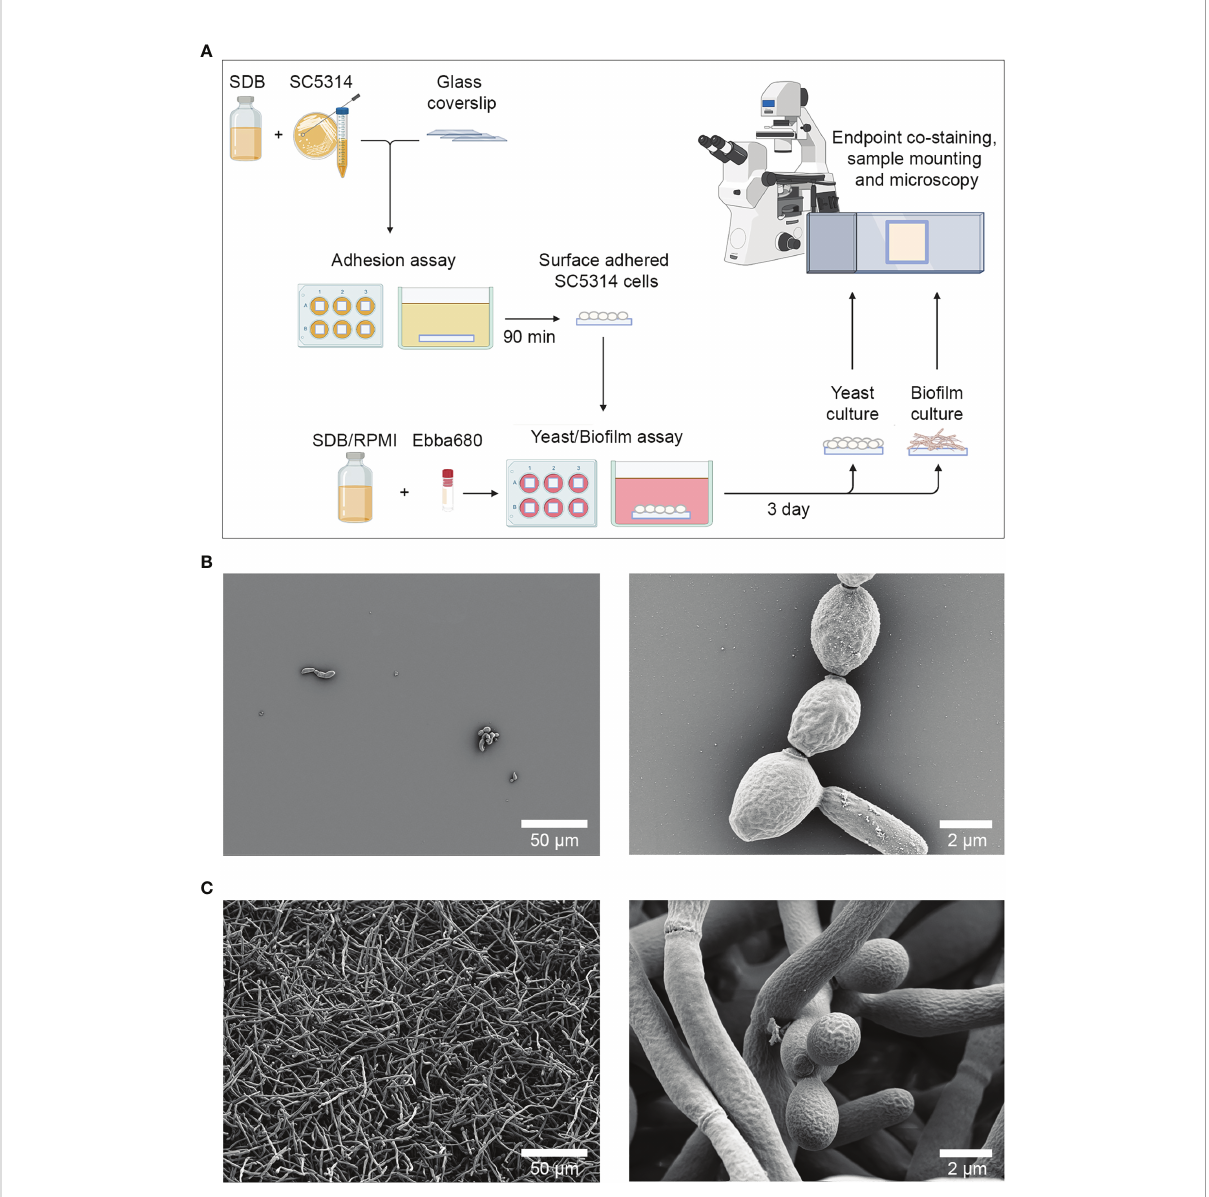
FIGURE 1 Cultivation of surface adhered C. albicans yeast cells and bio fi lms. (A) Work fl ow for producing yeast cells and bio fi lms. Sterile glass coverslips were immersed in 2 mL of C. albicans in SDB for 90 min at 37°C, after which coverslips containing adhered cells were re-incubated in 2 mL of SDB or RPMI with or without Ebba680 in 6 well plates for 3 days at 37°C. Surface adhered yeast cells and bio fi lms were subsequently analyzed by scanning electron microscopy, immuno fl uorescence techniques, confocal microscopy and spectral imaging analysis. (B) Scanning electron micrographs of surface adhered yeast cells at low (left) and higher magni fi cations (right). (C) Scanning electron micrographs of bio fi lm cells at low (left) and higher magni fi cations (right). Representative images of three independent experiments are